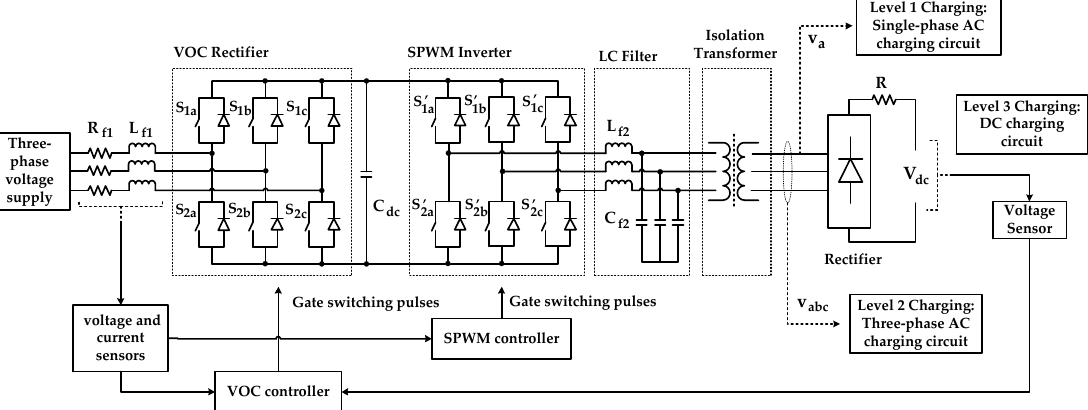
Figure 1. The proposed electric vehicle (EV) universal charger of three-stage converters based on the voltage-oriented control (VOC) algorithm.